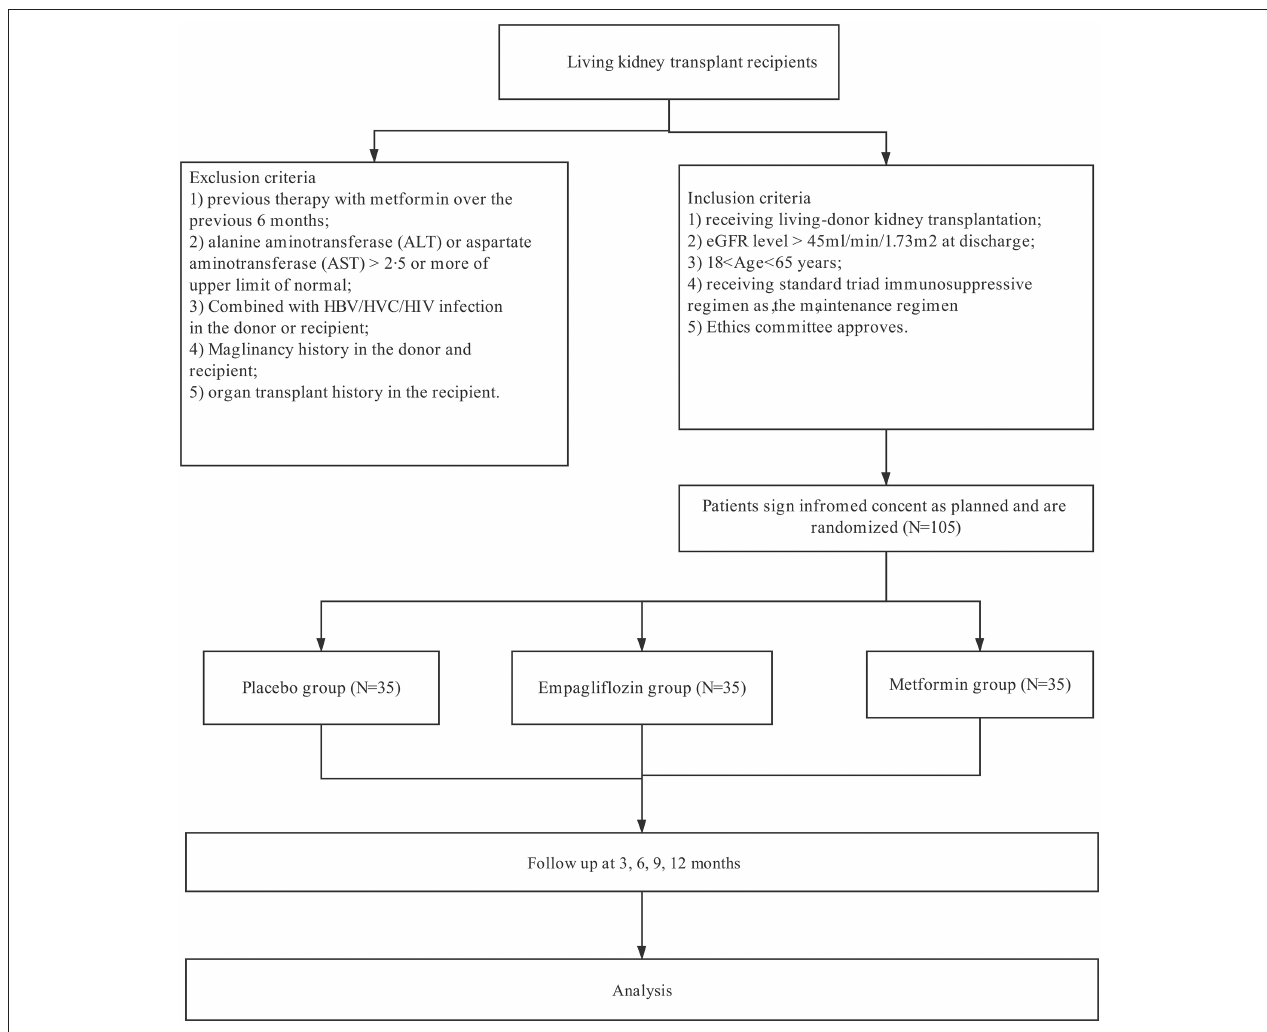
FIGURE 1 | Patients